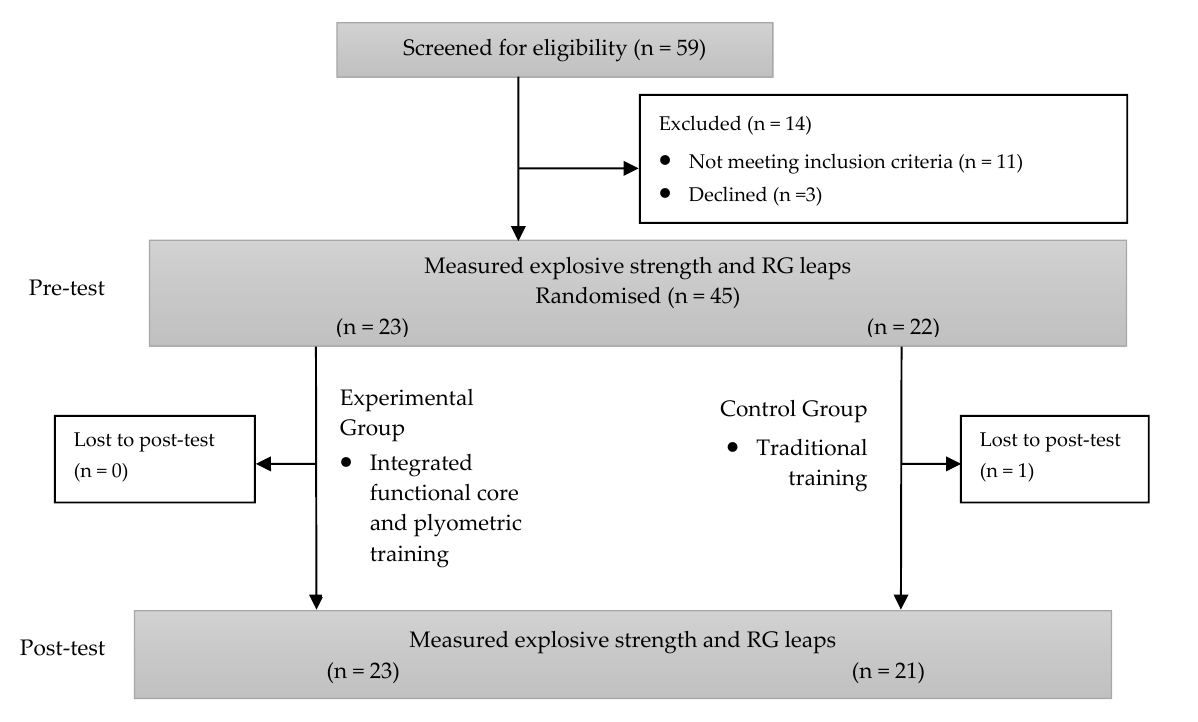
Figure 1. Sample flowchart. Table 1. Participants’